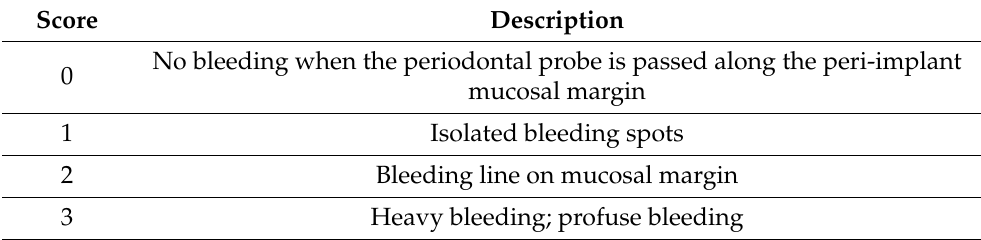
Table 5. mGI Indice (peri-implant soft tissues